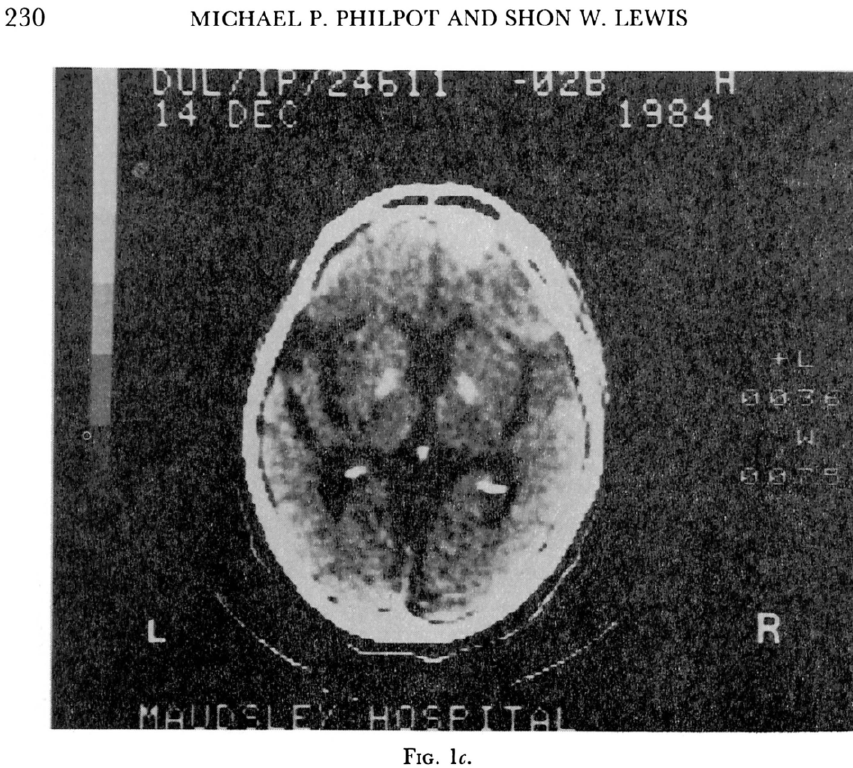
FIG. I. Examples of globus pallid us calcification of varying severity: (a) faint BGC in a 73- year-old woman with depressive anxiety; (b) definite BGC in a 71-year-old woman with vascular dementia; (c) dense BGC in a 60-year-old man with vascular